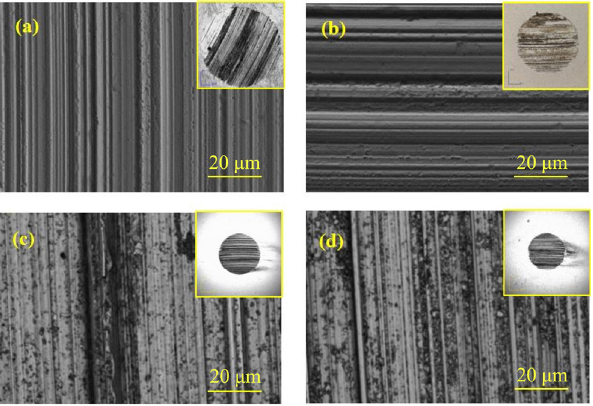
Fig. 8 SEM images of the worn surface lubricated by the additives at an optimum concentration of 0.15 wt% in the base oil at 392 N for 60 min: (a) base oil, (b) SiO 2 , (c) B–N–GO, and (d) SiO 2 –B–N–GO.